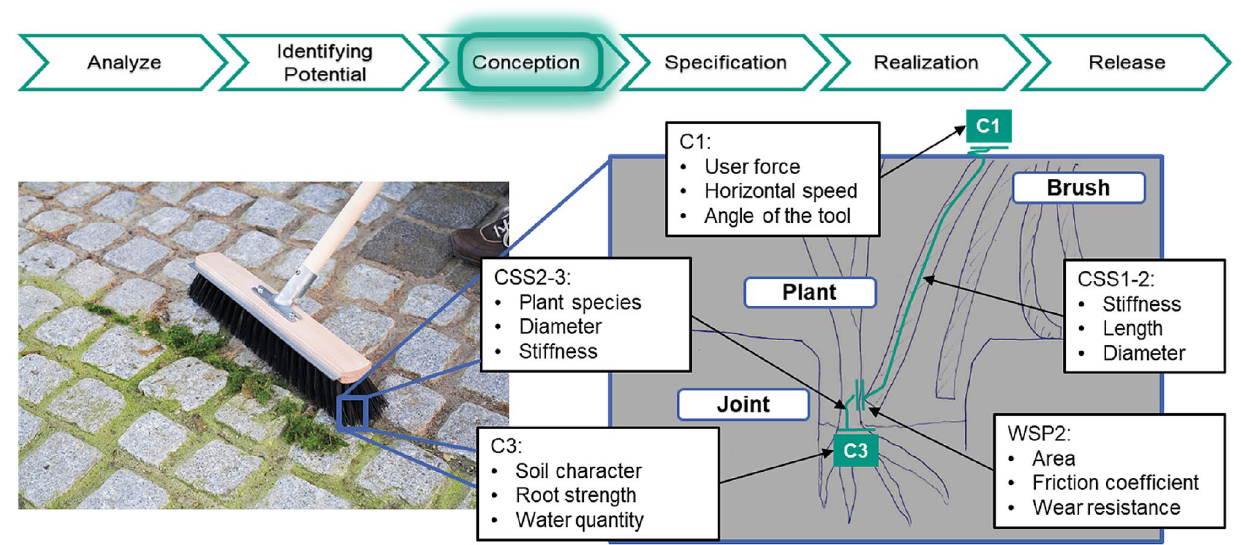
Fig. 9 C&C 2 -Model of EFRs of a reference